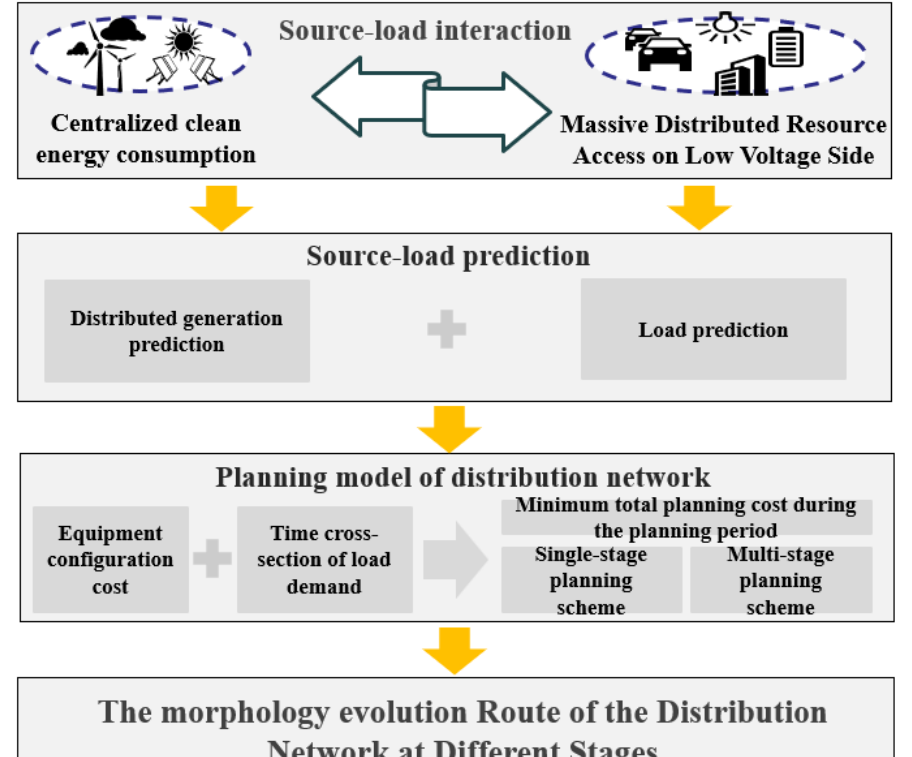
Figure 1. Analysis framework of multi-stage morphological evolutionary route of distribution net- work.